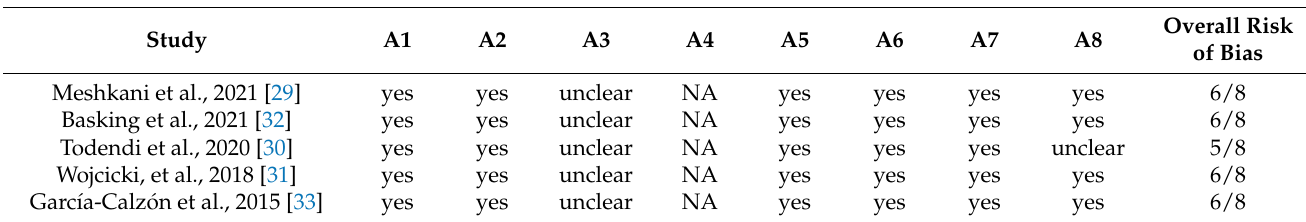
Table 2. Quality assessment of the included studies using the Joanna Briggs Institute Critical Ap- praisal Checklist for Analytical Cross-Sectional